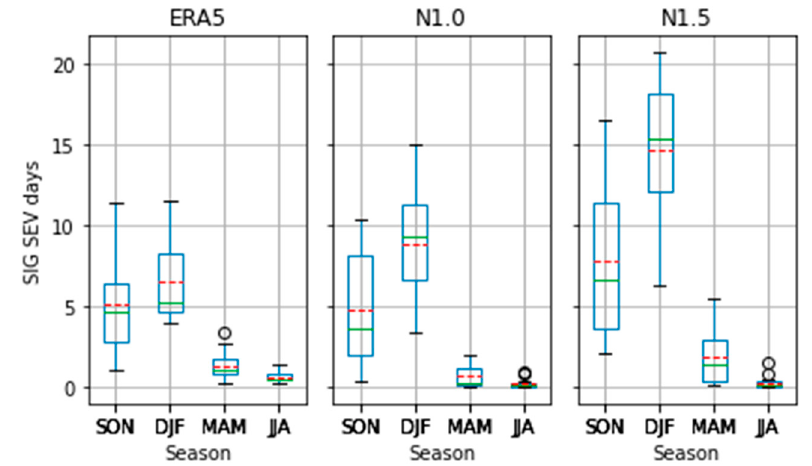
Figure 15. As in Figure 14 except for significant severe thunderstorm potential.